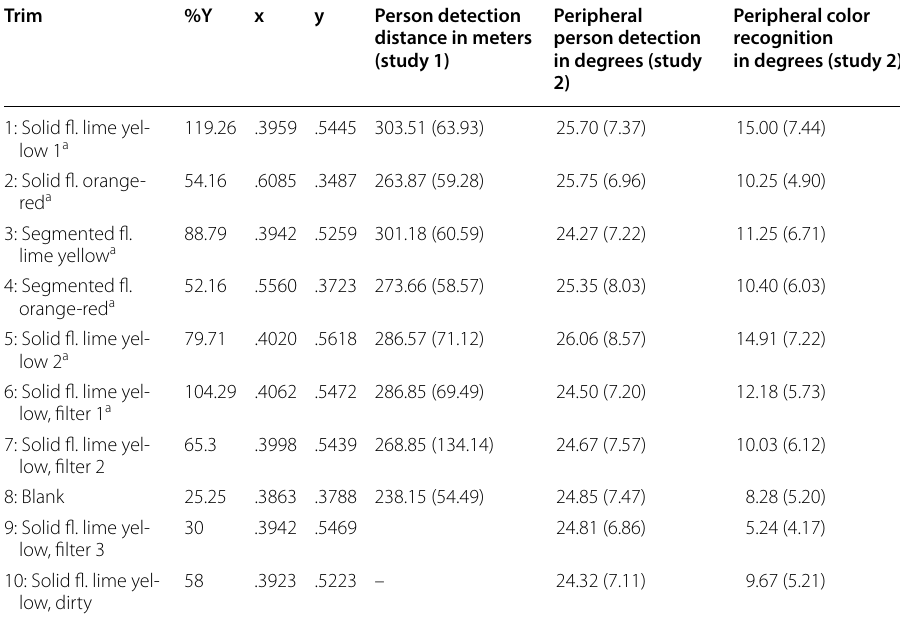
Table 1 Trim characteristics (%Y and chromaticity coordinates at illumination D65 and 45/0 geometry with 2° standard observer and a black underlay) and conspicuity measures (person detection distance, peripheral person detection angle, and